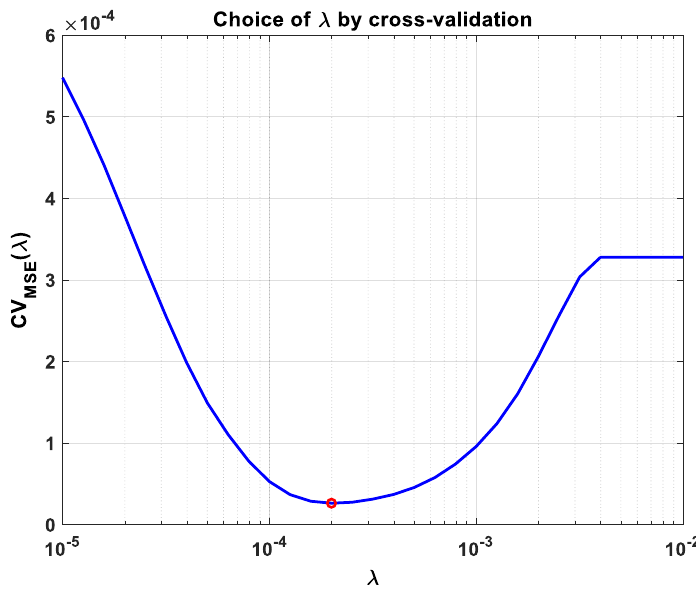
Figure 2. Choice of optimal λ value (red circle) using the cross-validation method.